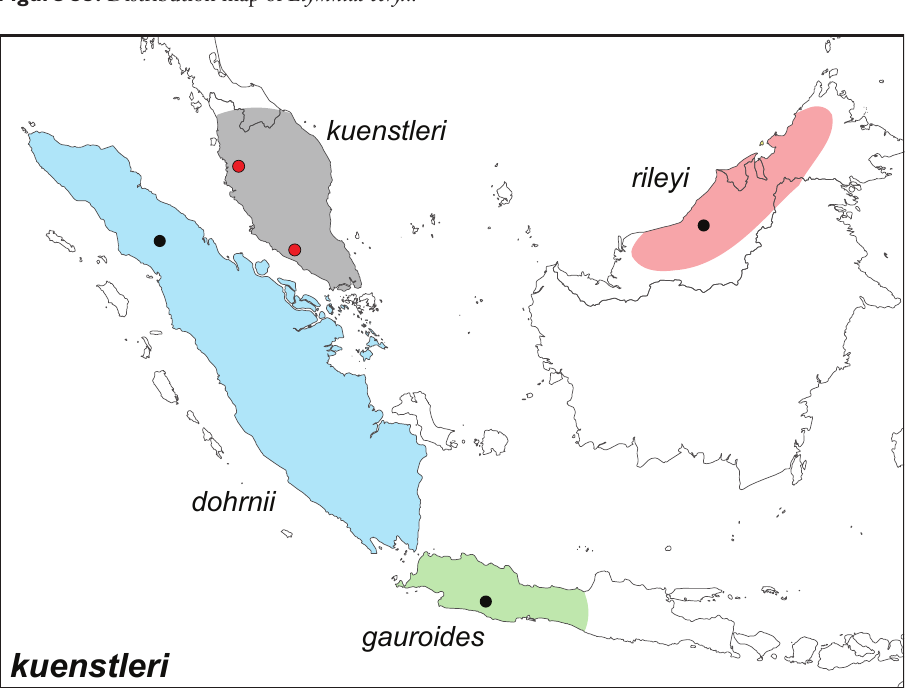
Figure 36. Distribution map of Elymnias kuenstleri